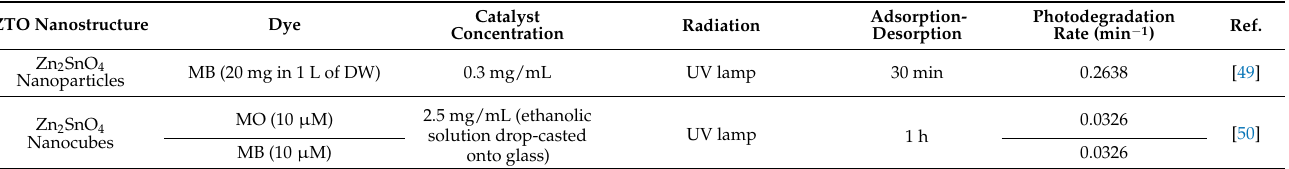
Table 1. Photocatalytic performance of different ZTO nanostructures in the degradation of pollutants. ZTO Nanostructure Dye Catalyst Concentration Radiation Adsorption- Desorption Photodegradation Rate (min − 1